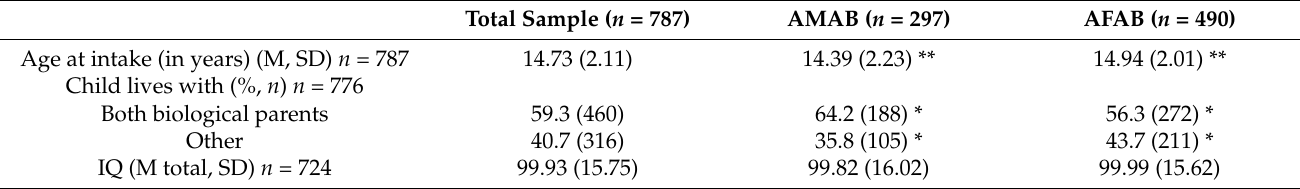
Table 1. Descriptive characteristics of the study population: total sample and separated based on birth-assigned